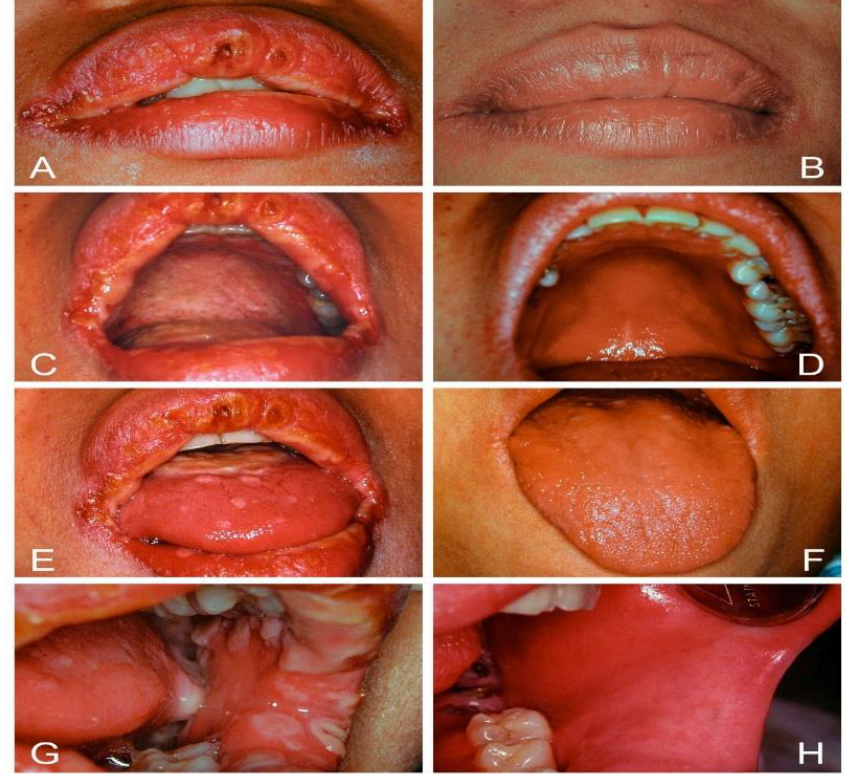
Figure 6. ( A , C , E , G ) Oropharyngeal candidosis resulting in high fever and potential candidemia in a 24-year-old woman with systemic lupus erythematosus and uremia who was refractory to therapy with nystatin suspension, ketoconazole, and vancomycin for one week in a local hospital. ( B , D , F , H ) After prescription with fluconazole combined with nystatin tablets, she showed no fever 2 days later and complete response within one month.